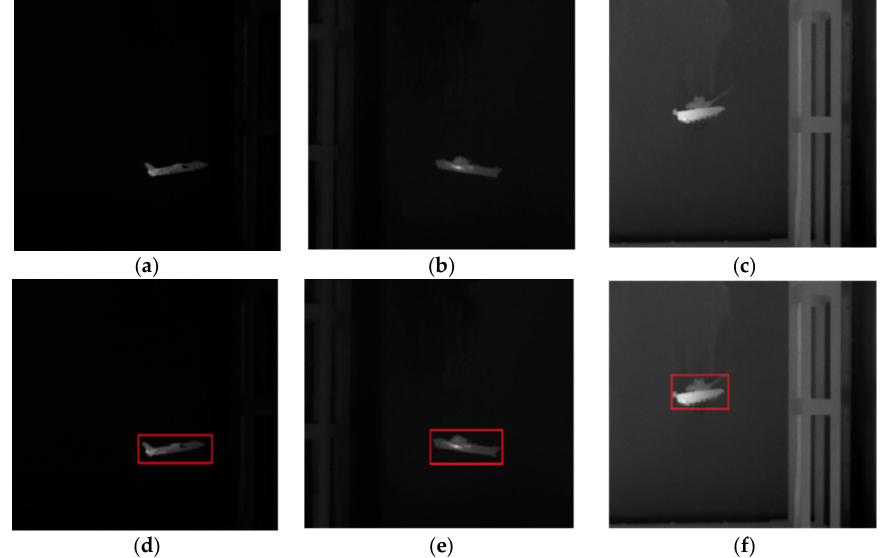
Figure 11. Images corrupted with the multiplicative noises and initial contours in the experiment. ( a ) “planeN2”; ( b ) “shipN2”; ( c ) “tankN2”; ( d ) Initial contour of “planeN2” (size: 170 × 75); ( e ) Initial contour of “shipN2” (size: 156 × 85); ( f ) Initial contour of “tankN2” (size: 125 × 95).